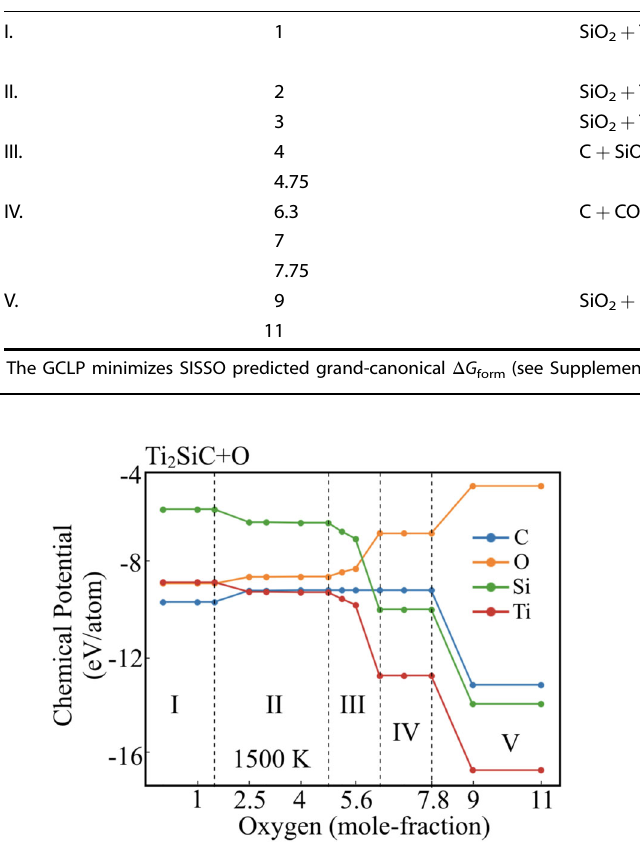
Fig. 4 Chemical activity of elements during oxidation process. Oxidation reaction chain showing change in chemical potential of Ti 2 SiC as a function of changing molar percent oxygen at 1500 K. On oxidation, the partial chemical potentials of Ti/Si/C reduce while the chemical potential of invading O 2